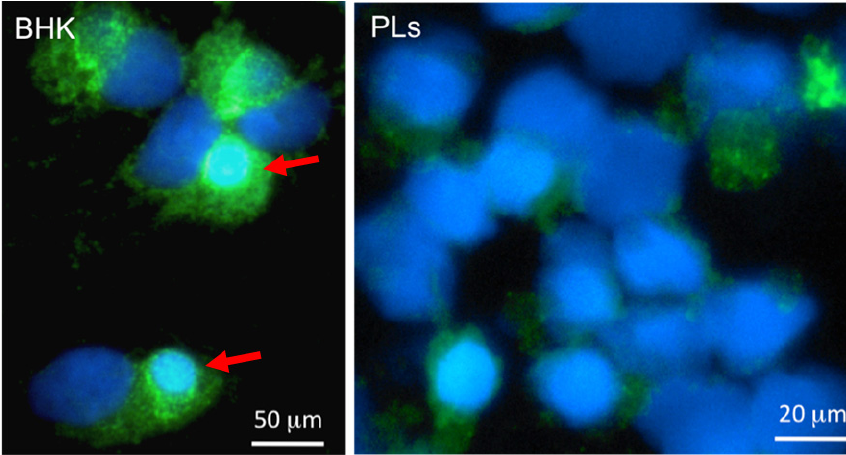
Figure 4. Immunofluorescence microscopy of baby hamster kidney cells (BHK, left) and Xenopus PLs infected in vitro for 2 days with FV3 (0.3 MOI). Cells were cytocentrifuged on microscope slides, fixed with formaldehyde, permeabilized with ethanol, incubated with a rabbit anti-53R and FITC-conjugated donkey anti-rabbit Abs (Green); then stained with the DNA dye Hoechst-33258 (Blue) mounted in anti-fade medium and visualized with a Leica DMIRB inverted fluorescence microscope. Note the large viral assembly sites in BHK cells that contain large amount of viral DNA stained Hoechst-33258 and anti-53R Ab (arrows). In contrast, anti-53R staining is weaker in PLs, and no assembly sites are